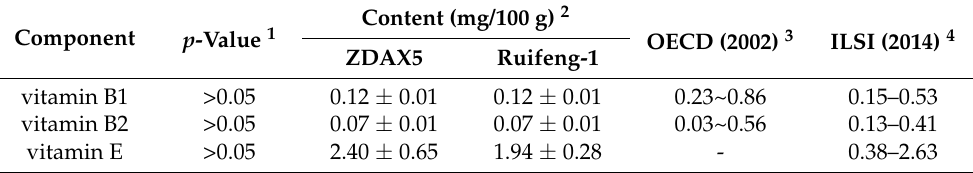
Table 4. Vitamin levels in ZDAX5 maize grain and Ruifeng-1 maize grain.